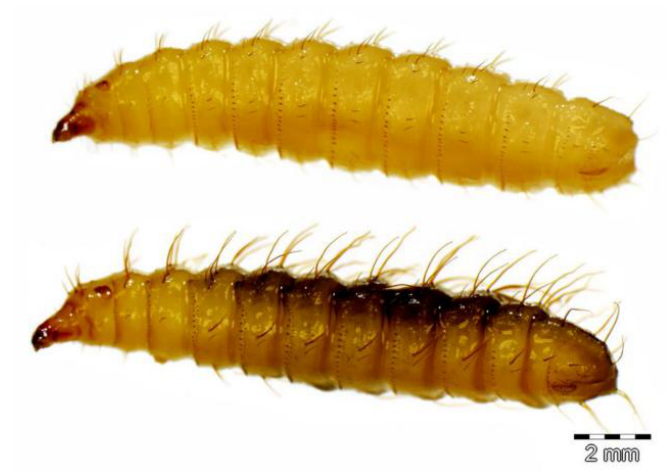
Figure 4. Habitus of the stratiomyid larvae of Hermetia illucens ( top ) and H. fenestrata ( bottom ) in lateral view.